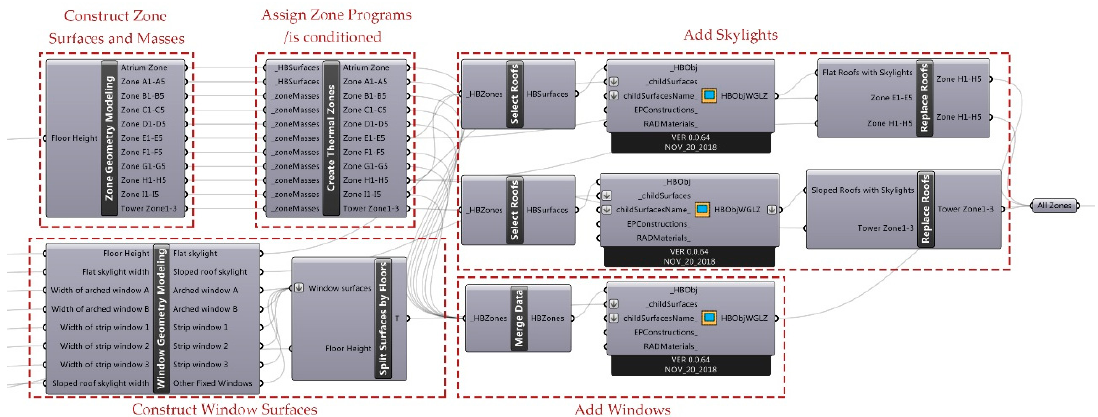
Figure 7. The parametric simulation modeling module.